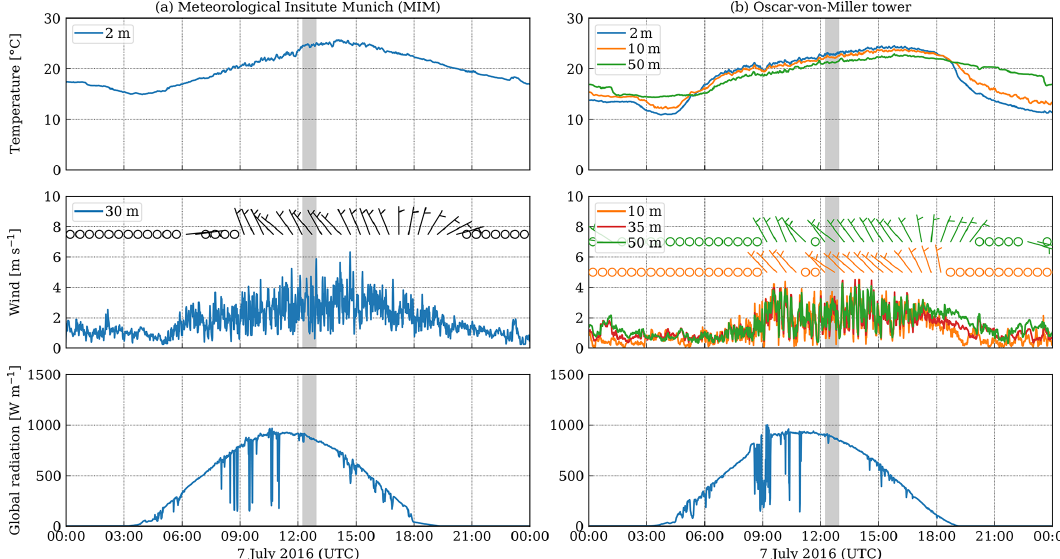
Figure 2. Time series of meteorological observations (temperature, wind speed and direction, and global radiation) at (a) the Meteorological Institute Munich (MIM) and at (b) the Oscar-von-Miller (OvM) tower. The APEX flight time is shown as a gray